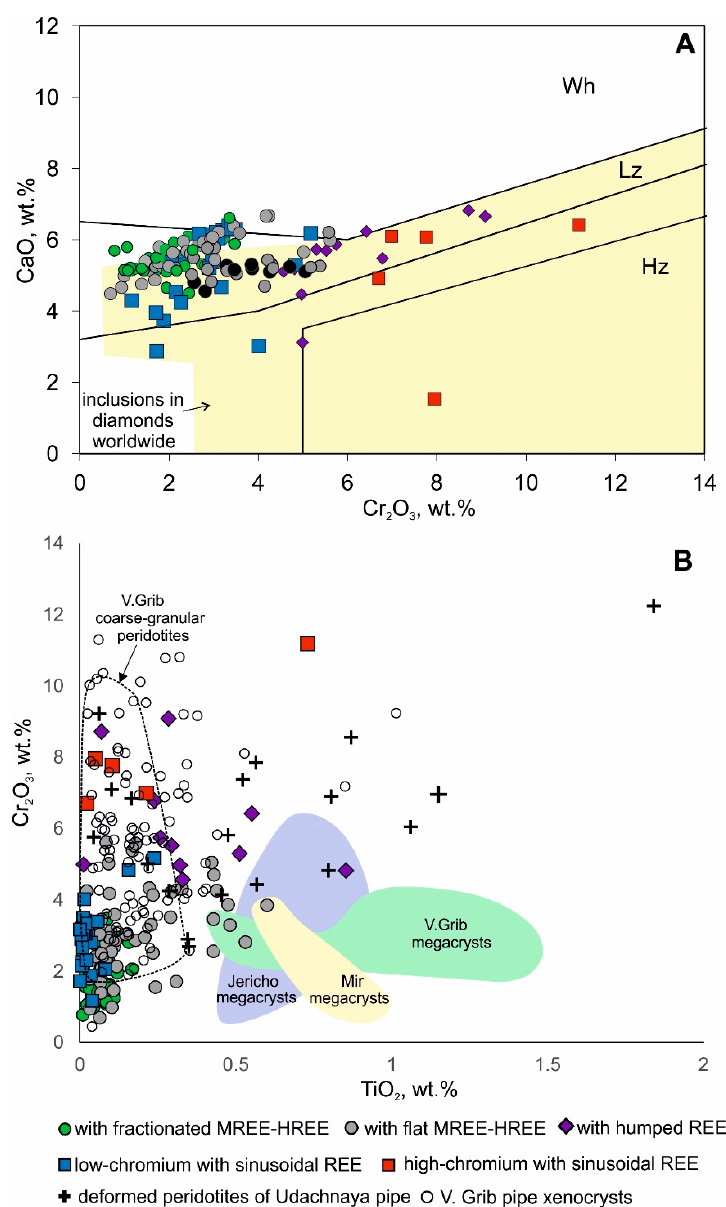
Figure 2. Cr 2 O 3 vs. CaO ( A ) and TiO 2 ( B ) of pyropes from the southern area of Arkhangelsk region compared with pyropes from: diamond inclusions worldwide [12,13], the V. Grib pipe coarse-granular peridotites [14], xenocrysts and megacrysts [15,16], Jericho [17] and Mir megacrysts [18], and Udachnaya deformed peridotites [19]. The fields for lherzolitic, harzburgitic, and wehrlitic pyropes from [10]. MREE, middle REE; HREE, heavy REE.